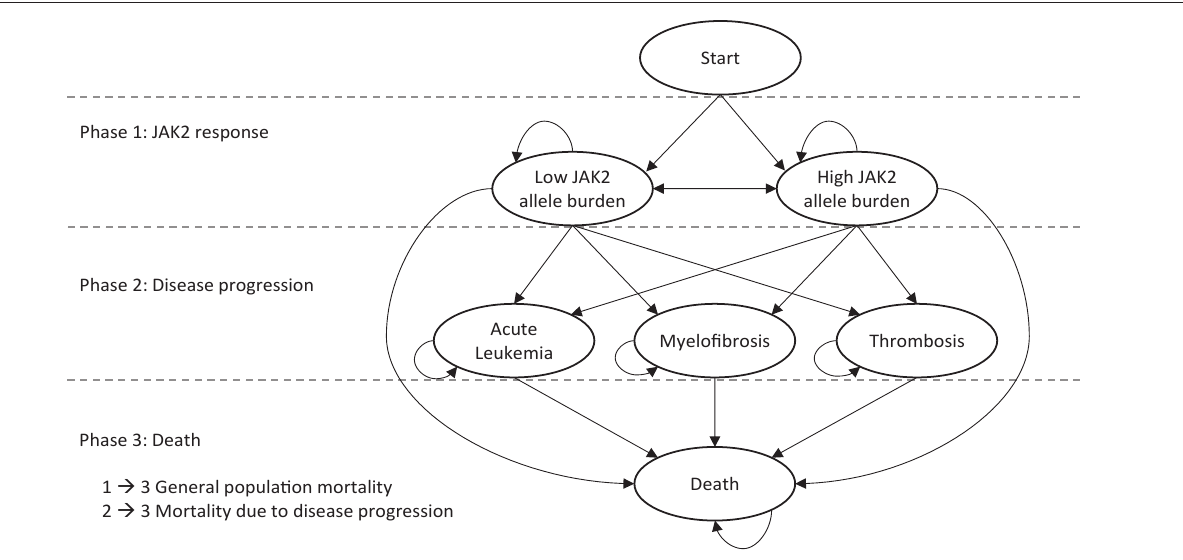
Low JAK2 allele burden